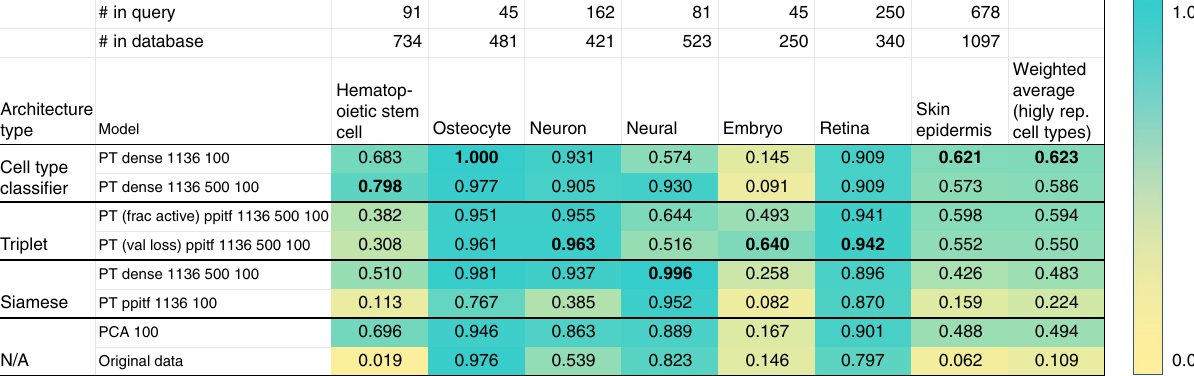
Fig. 3 Neural embedding retrieval testing results. Retrieval testing results of various architectures, as well as PCA and the original (unreduced) expression data. Scores are MAFP (mean average fl exible precision) values (Supporting Methods). “ PT ” indicates that the model had been pretrained using the unsupervised strategy (Supporting Methods). “ Ppitf ” refers to architectures based on protein – protien and protein – DNA interactions (Supporting